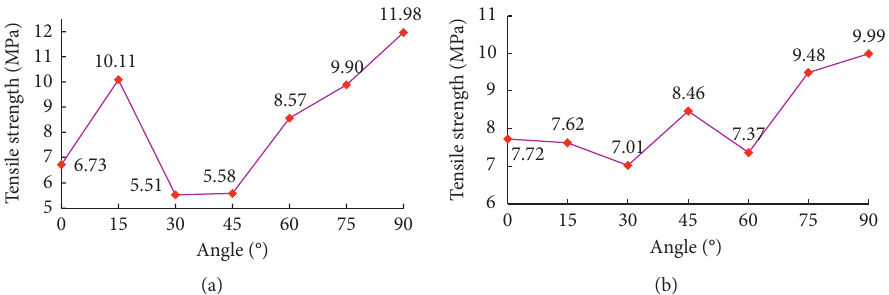
Figure 16: Tensile strength changes of the center points of the bedding model with different angles. (a) Uniformly parallel. (b) Unevenly parallel.